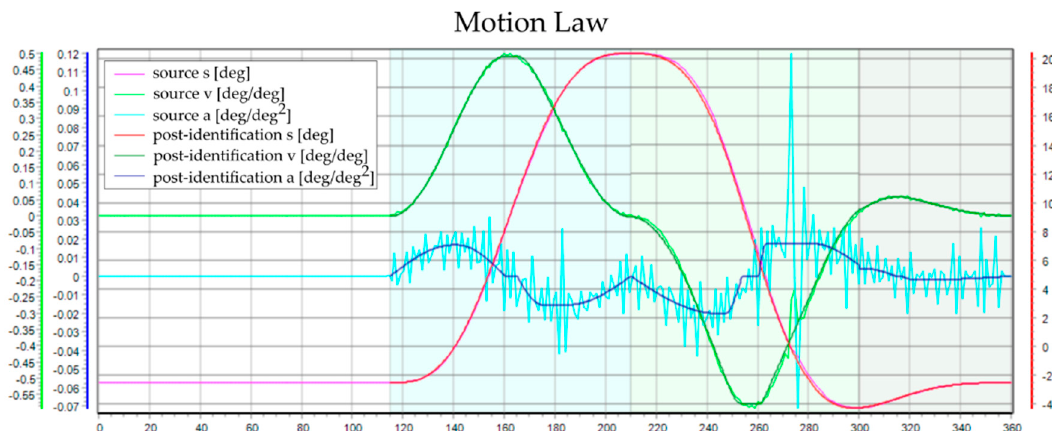
Figure 13. Comparison between the experimental law of motion (light blue) and modified trapezoidal laws for each phase (with equal coefficients values) after identification based on velocity by adopting the EN.